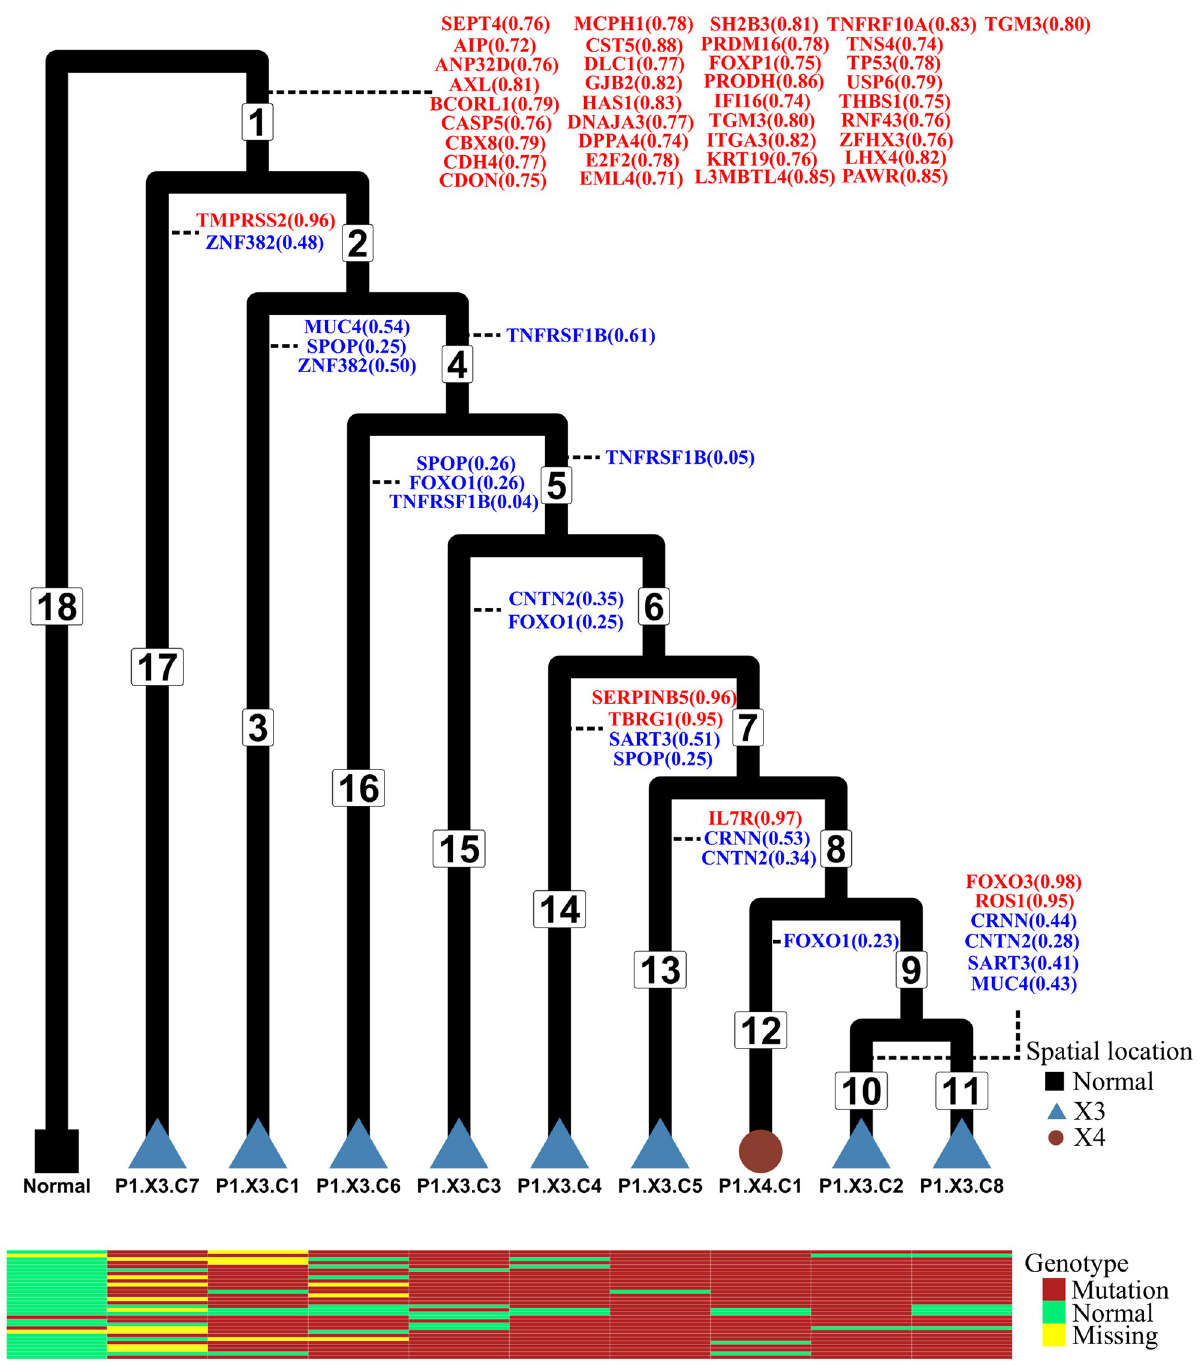
Fig 7. P1 tumor phylogenetic tree and inferred temporal order of the mutations. The normal cell is set as the outgroup. There are 18 branches in this tree. We do not assume the molecular clock when estimating the branch lengths. Branch lengths in this figure are not drawn to scale. The color and tip shape represent the spatial locations of the samples (normal tissue, location X3 or location X4; see [31]). The temporal order of the mutations is annotated on the branches of the tree. Mutations with very strong signals (probability of occurring on one branch is greater than 0.7) are highlighted in red, while mutations with moderate signals (probabilities that sum to more than 0.7 on two or three branches) are highlighted in blue. Mutation data for 30 genes corresponding to the first 30 rows in Figs R and S in the S1 Text for each tip are shown in the heatmap matrix at the bottom.